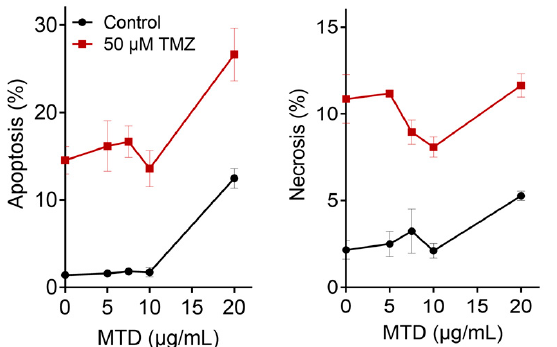
Figure 7. E ff ect of MTD alone (control) and in combination with TMZ (20 µ M) on TMZ-induced apoptosis and necrosis, measured by AV / PI flow cytometry. Cells were harvested and analyzed 96 h Figure 7. Effect of MTD alone (control) and in combination with TMZ (20 µM) on TMZ-induced after the addition of TMZ and MTD to the apoptosis and necrosis, measured by AV/PI flow cytometry. Cells were harvested and analyzed 96 h after the addition of TMZ and MTD to the medium.